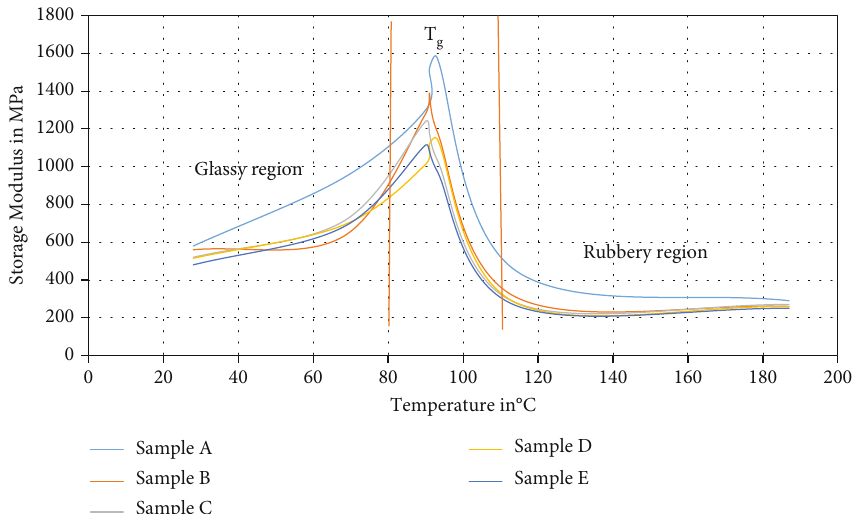
Figure 4: The storage modulus of the epoxy